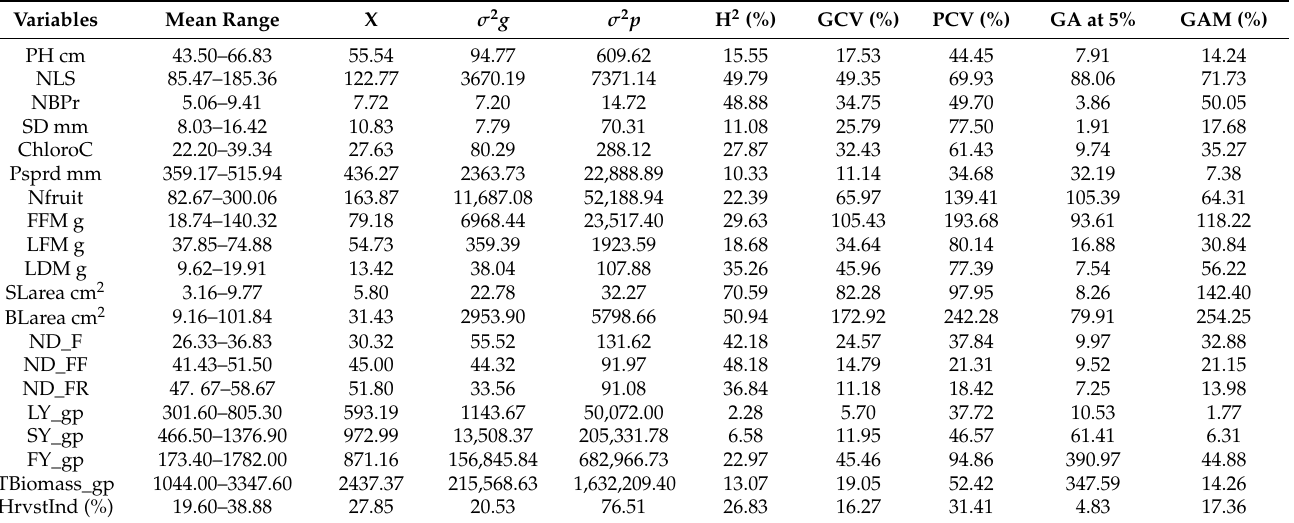
Table 4. Estimation of genetic parameters for agronomic and yield contributing traits of 15 nightshade accessions selected at 5% selection